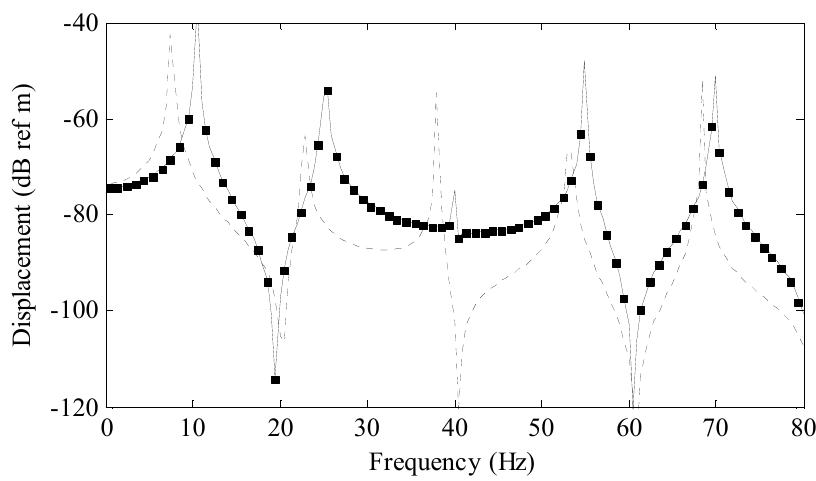
Figure 8. Displacement versus frequency for a rod with a first kind, zero order Bessel function cross-sectional area. The solid line is the series solution, the square markers are the finite element solution and the dashed line is the baseline model with uniform cross-sectional area.